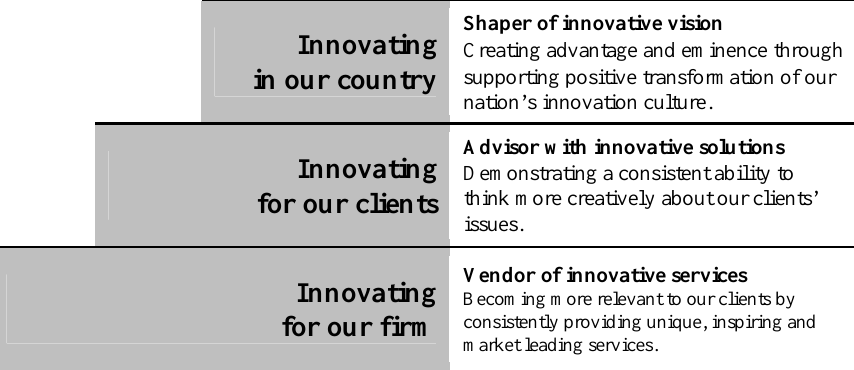
Fig. 4. The firm’s Innovation